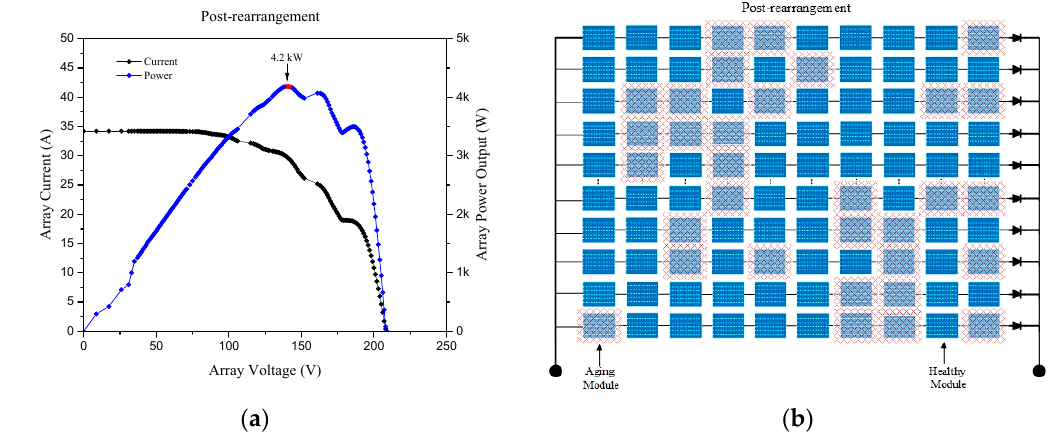
Figure 4. The output result for the 10 × 10 PV array. ( a ) PV array with the rearrangement. ( b ) The aging modules were covered with a plastic cap for